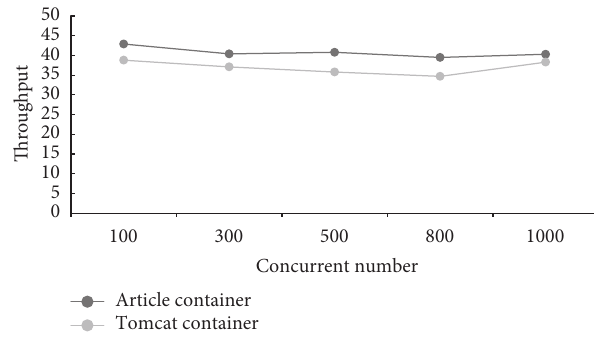
Figure 7: Throughput comparison of two containers.